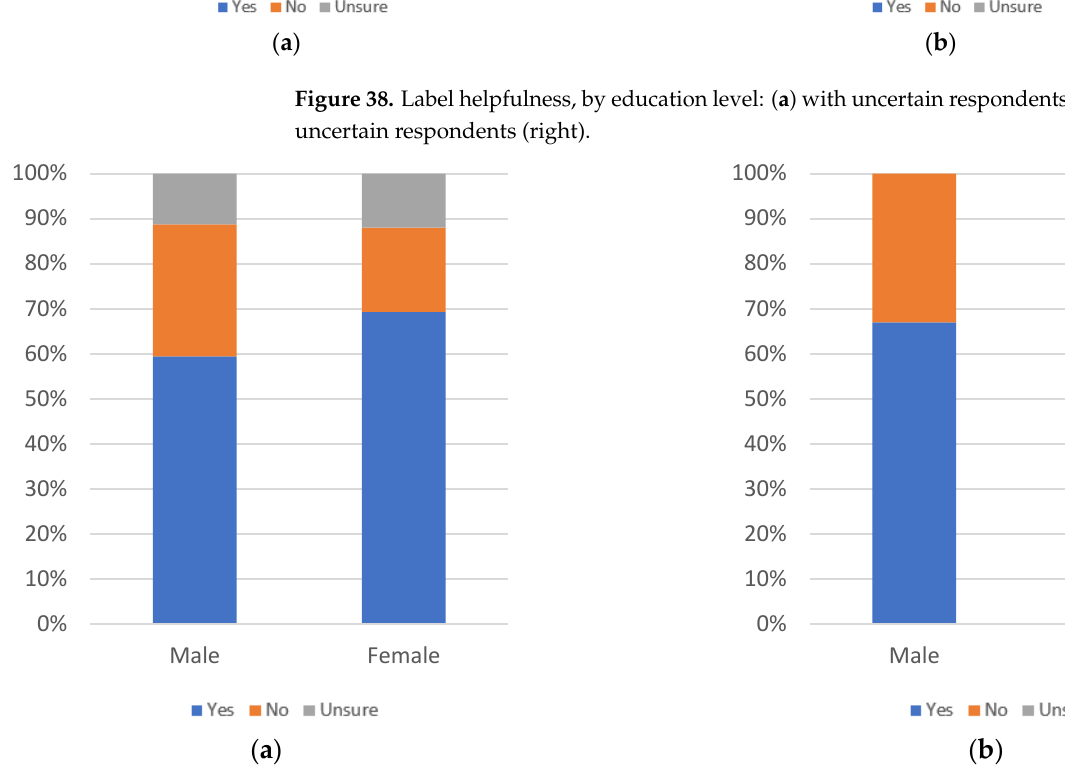
Figure 39. Label helpfulness, by gender: ( a ) with uncertain respondents (left) and ( b ) without uncertain respondents (right).